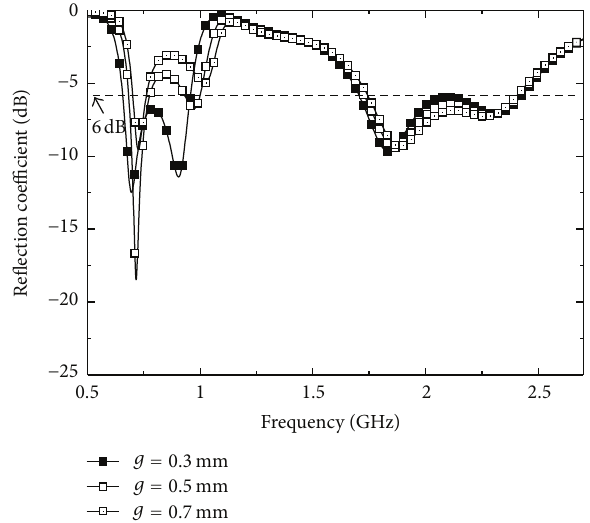
F 6: Simulated re�ection coe�cients relative to changes in the gap between feeding pad and coupling strip